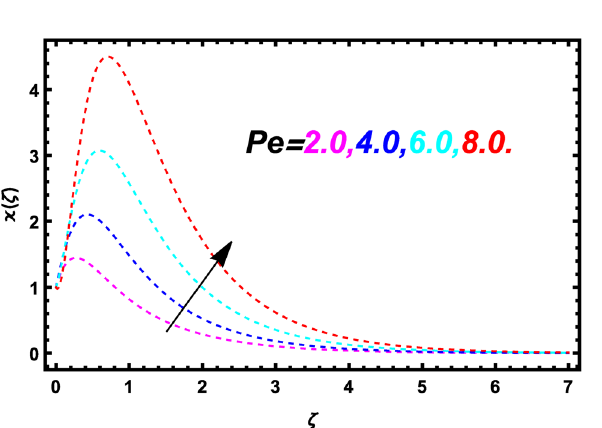
Figure 24. Change in gyrotactic microorganism profile due to Lb when Fr = 0.2, k 1 = 0.1, k 2 = 0.3, M = 0.5, m = 0.2, Pr = 5.3, φ = 0.01, Ec = 0.3, ε t = 3.0, Rd = 0.2, Sc = 0.1, ε C = 3.0, δ = 0.3, Pe =